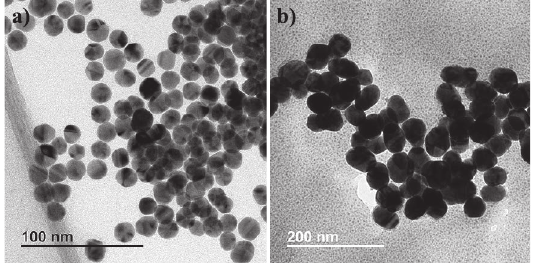
Fig. 3 TEM images of as-synthesized AuNPs a) MR = 2.80, mean size = 15 nm, batch size = 1.5 L; b) MR = 1.50, mean size = 50 nm, batch size = 1.5 L.